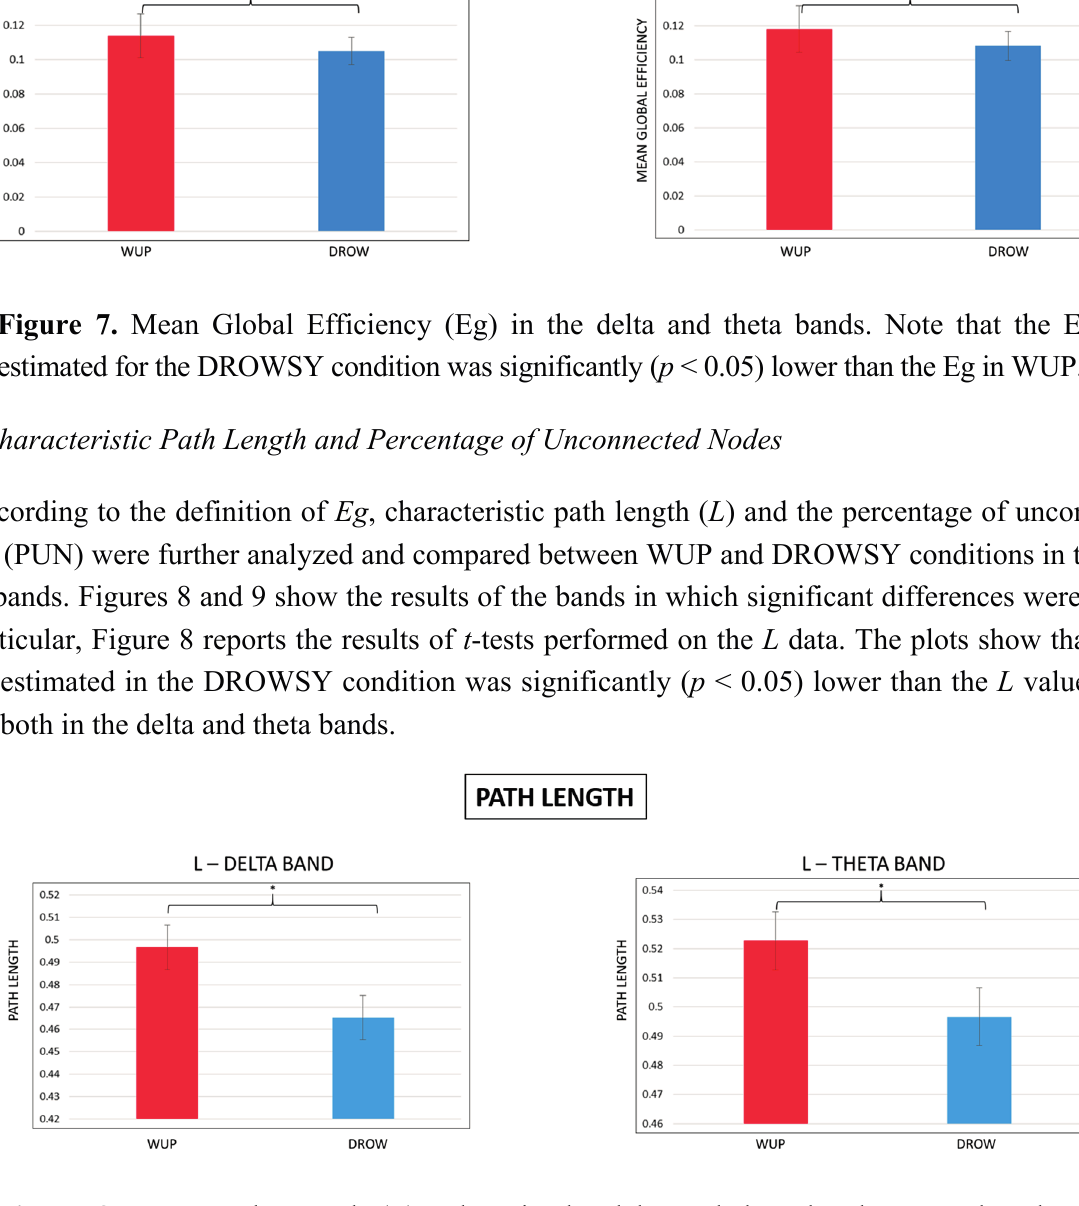
Figure 8. Mean Path Length (L) values in the delta and theta bands. Note that the